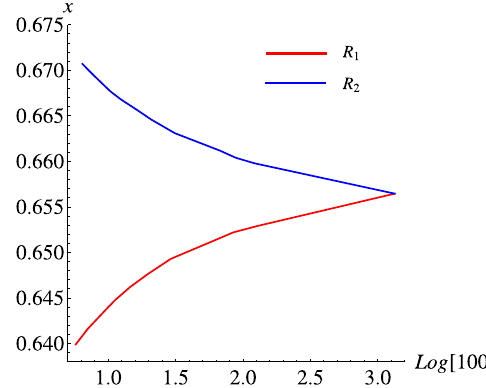
Fig. 11 The scalar curvature of two phases in the coexistent states